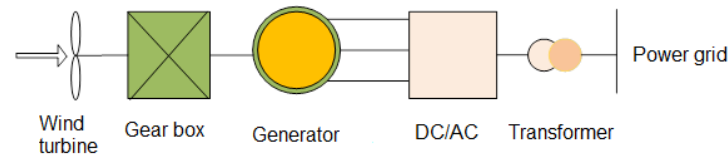
Figure 2. Conversional transformation of a power system from wind energy.